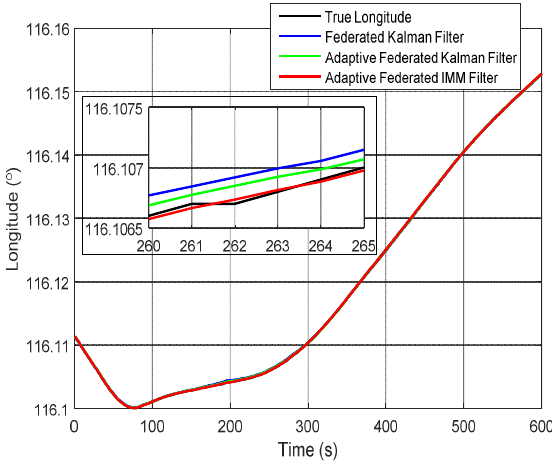
Sensors 2020 , 20 , x FOR PEER REVIEW Figure 19. The estimation curves of longitude. Figure 19. The estimation curves of longitude.